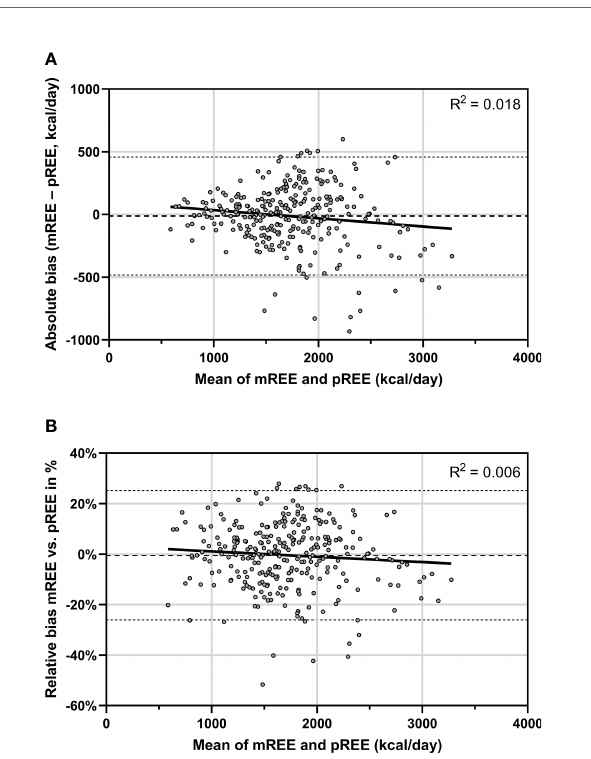
FIGURE 3 | Bland-Altmanplotfor theagreementbetweenmREEandpREE(by Scho fi eldequations). Thedotsrepresent theindividualpatients. Themiddledashed linerepresents themeanabsolute (A) or relativebias (B) acrossthestudy population. Theupper andlowerdashedlines representtheupperandlower limits ofagreement(meanbias± 1.96SD)ofmREEandpREE.Thesolidlinerepresents thelinear regression fi tline. mREE, measuredrestingenergyexpenditure; pREE, predictedrestingenergyexpenditure(usingtheScho fi